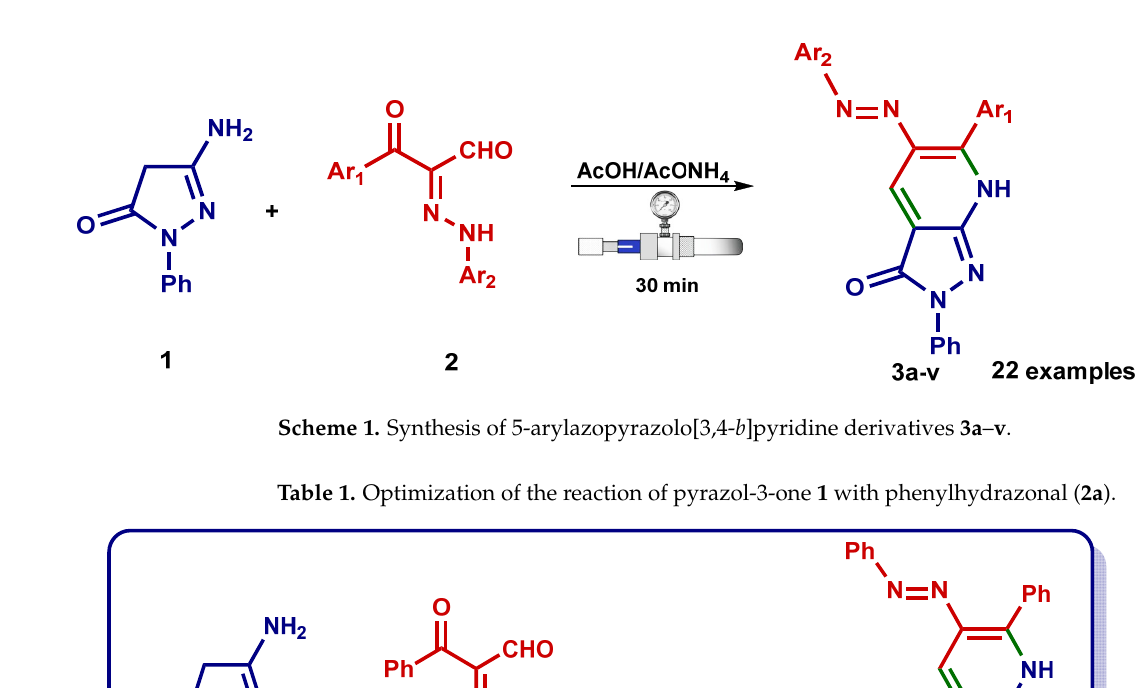
Molecules 2022 , 27 , x FOR PEER REVIEW 8 of 15 283–284 °C; FT-IR 𝜈 /cm − 1 : 3122 (NH), 1661 (C=O), 1620 (C=N); 1 H NMR (DMSO- d6 , 600 MHz): δ 2.89 (s, 3H, C H 3 ), 7.18 (t, J = 7.8 Hz, 1H, Ar-H), 7.44 (t, J = 7.8 Hz, 2H, Ar- H), 7.49 (t, J = 7.8 Hz, 1H, Ar-H), 7.56 (t, J = 7.8 Hz, 2H, Ar-H), 7.84 (d, J = 7.8 Hz, 2H, Ar-H), 8.07 (d, J = 7.8 Hz, 2H, Ar-H), 8.42 (s, 1H, C-H4), 13.94 ppm (s, 1H, NH); 13 C NMR (DMSO- d6 , 150 MHz): δ 17.74 ( C H 3 ), 119.20, 122.75, 124.14, 124.89, 129.24, 129.77, 130.95, 135.71, 139.62, 152.71, 157.89, 160.03 ppm; MS (EI) m/z (%): 330 (M + + 1, 23.91), 329 (M + , 100.00), 328 (M + − 1, 8.23); HRMS (EI) m/z : [M] + calcd for C 19 H 15 N 5 O (M + ) 329.1271, found 329.1271. 3. Results and Discussion